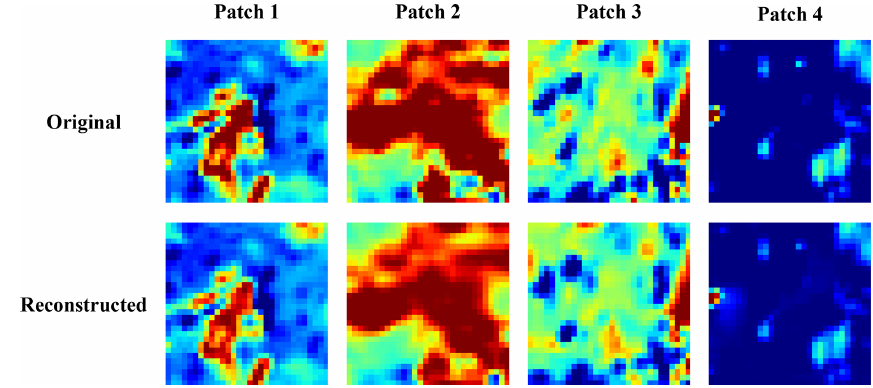
Figure 10. Detailed original and reconstructed spatial information of four simulated patches on 25 July 2015.